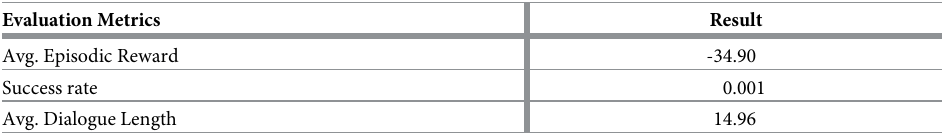
Table 10. GO-Bot performance for dynamic goal setting scenarios.